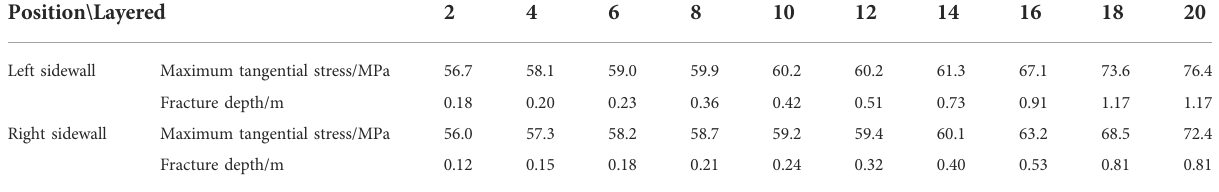
TABLE 2 Comparative analysis of the maximum tangential stress and fracture depth of the ramp surrounding rock.